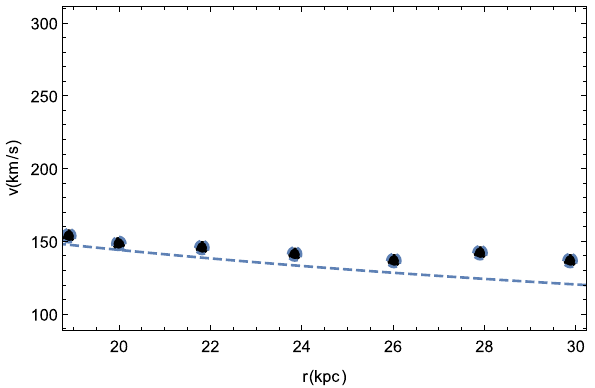
Fig. 4 The rotation curve external to the typical galactic disk of matter forthegalaxyNGC3198.Thedotsshowtheobserved[63,64]behaviour in the outer region of galactic luminous disk of matter. The dashed line shows the theoretically predicted rotation curve far from the galactic disk matter with M ≈ 11 . 0 × 10 10 M (cid:19) . The plot is obtained with = 10 2 . 250 kpc ≈ 177 . 80 δ ≈ 10 − 6 and the galactic scale parameter r 0